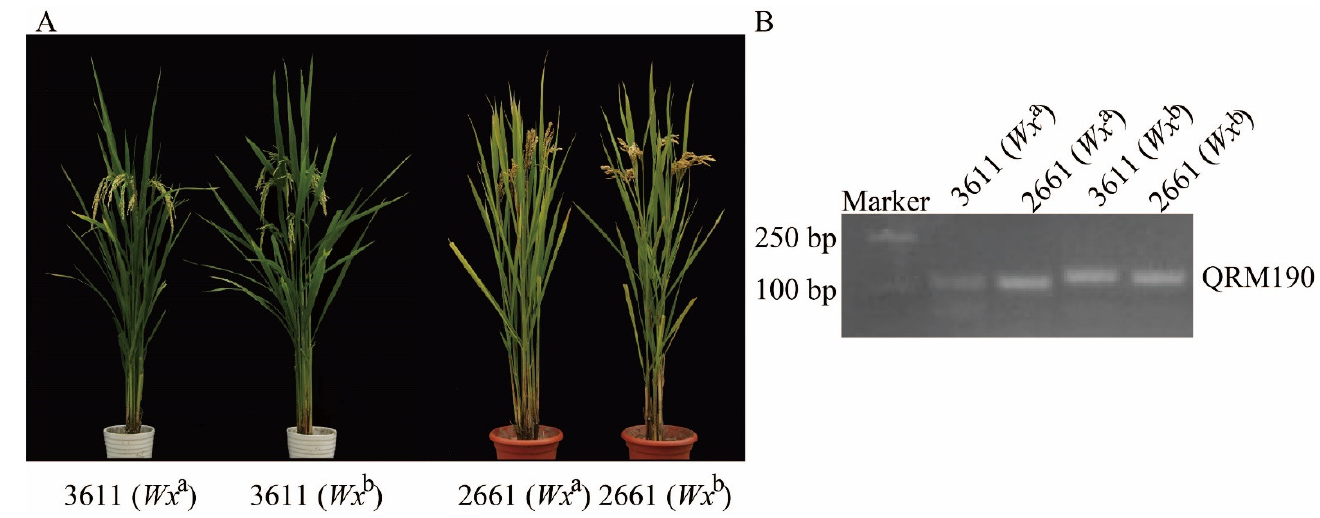
Figure 1. Construction of Wx NILs with 3611 and 2661 genetic backgrounds. ( A ) The plant phenotype of Wx NILs with 3611 and 2661 genetic backgrounds. ( B ) Genotyping of Wx alleles in the two Wx